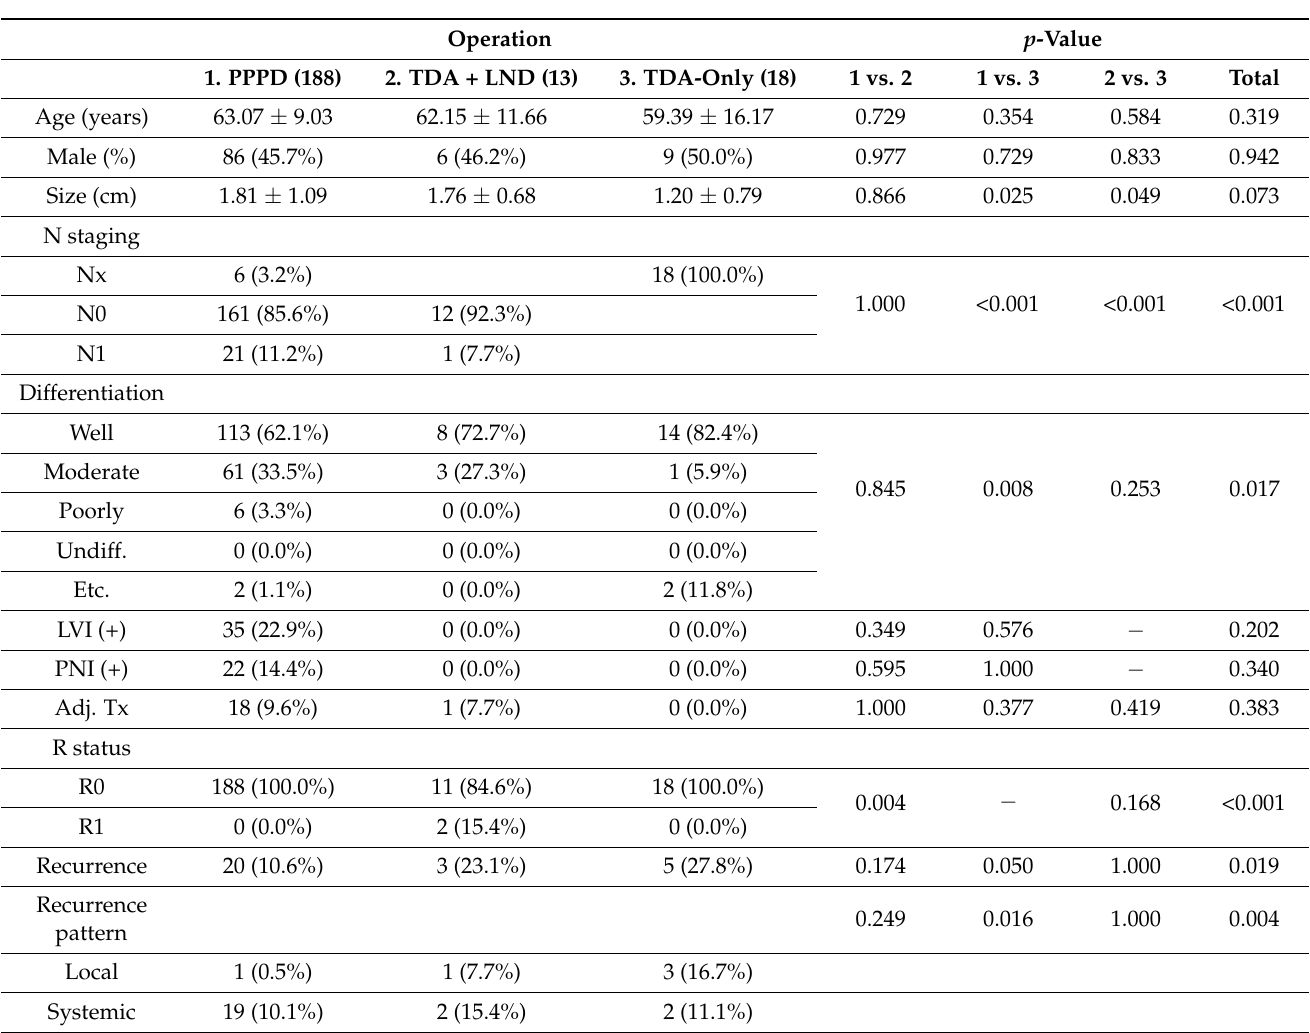
Table 2. Comparison of clinicopathologic characteristics and recurrence according to the operation type in patients with T1 stage